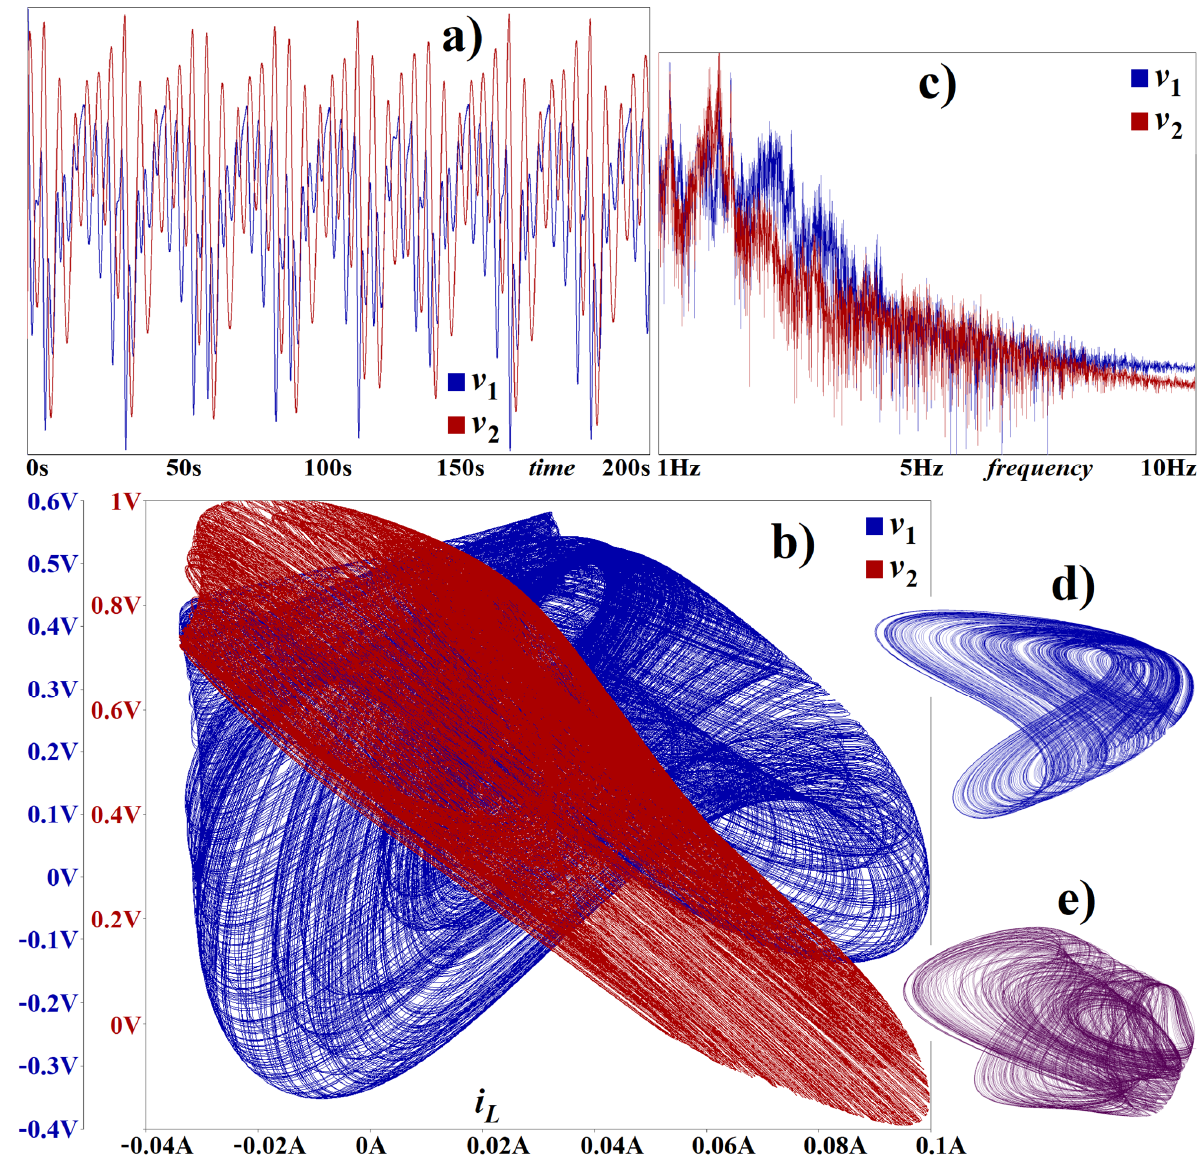
Figure 13. Idealized fourth-order system, selected Orcad Pspice simulation results: ( a ) signals v 1 and v 2 in time domain, ( b ) plane projections v 1 vs. i L and v 2 vs. i L , ( c ) baseband frequency spectrum of the generated signal v 1 and v 2 , ( d ) plane projection v 2 vs. v 1 , ( e ) plane projection v 3 vs. v 1 .